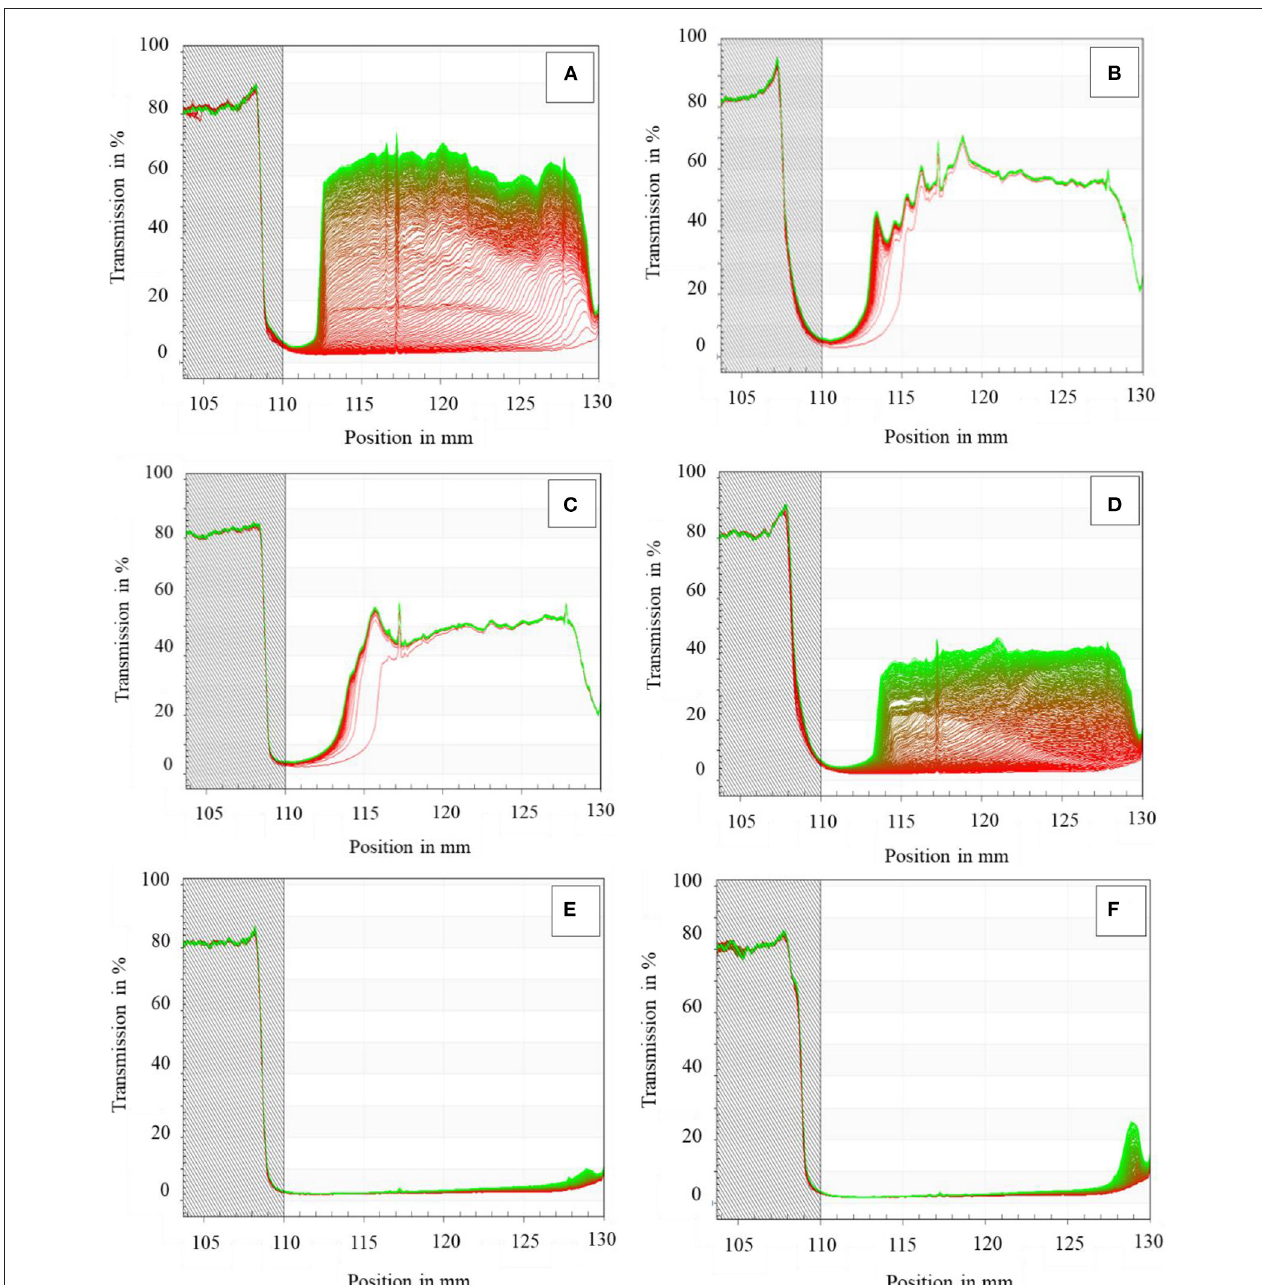
FIGURE 2 | Physical stability tested by LUMiSizer (original transmission) of the SPI-stabilized rice bran oil emulsions with different concentrations of CMC at pH 3.5, 25 ◦ C [ (A) 0 wt% CMC; (B) 0.125 wt% CMC; (C) 0.25 wt% CMC; (D) 0.375 wt% CMC; (E) 0.5 wt% CMC; and (F) 0.625 wt% CMC].